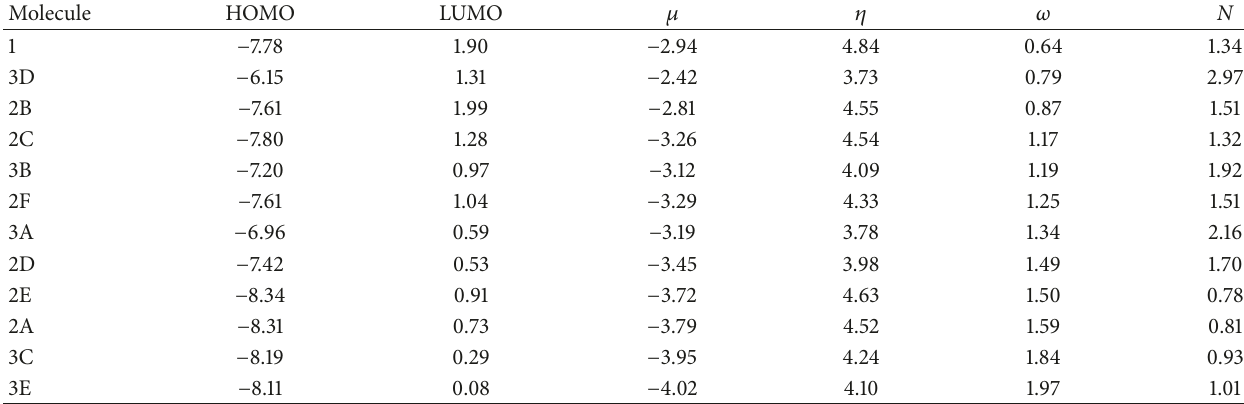
Table 3: Reactivity indices ∗ sorted according to ascending electrophilicity 𝜔 .